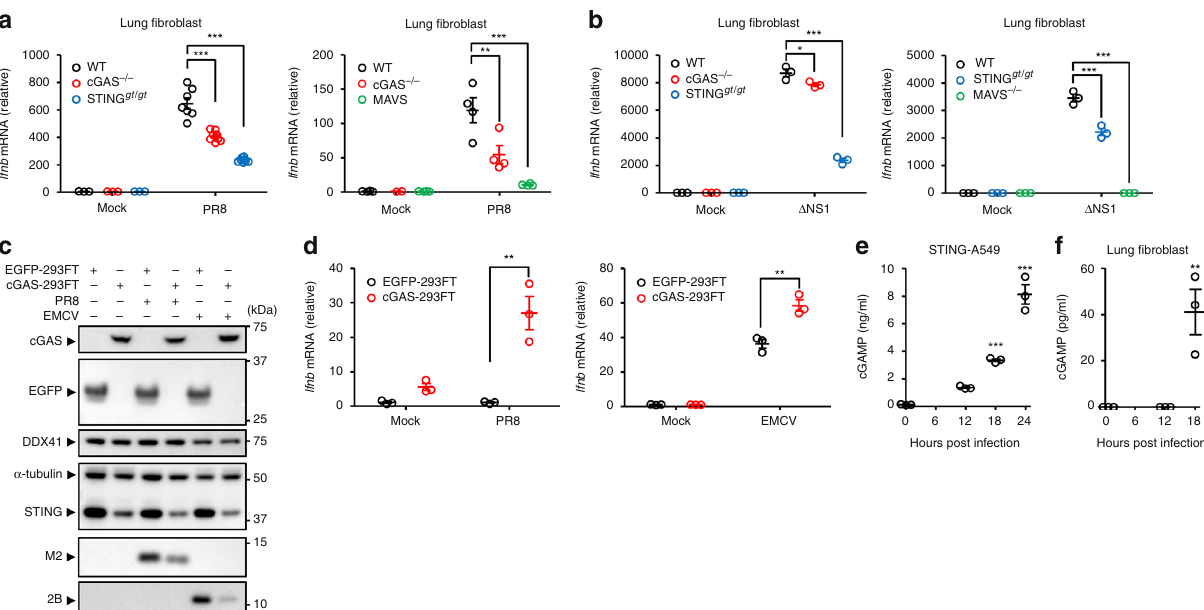
Fig. 4 In fl uenza virus stimulates cGAS- and STING-dependent IFN- β gene expression in mouse lung fi broblast. a , b Primary lung fi broblast prepared from WT, cGAS-, STING-, and MAVS-de fi cient mice were infected with WT PR8 ( a ) or Δ NS1 in fl uenza virus ( b ). IFN- β mRNA levels were assessed by quantitative PCR with GAPDH as an internal control. c Samples from HEK293FT cells stably expressing EGFP (EGFP-293FT) or cGAS (cGAS-293FT) were infected with PR8 or EMCV. Cell lysates were collected at 9 h post infection and blotted using the indicated antibodies. d EGFP-293FT or cGAS-293FT cells were infected with in fl uenza virus (left panel) or EMCV (right panel) for 24 h. IFN- β mRNA levels were assessed by quantitative PCR with β -actin as an internal control. e , f STING-A549 cells ( e ) or lung fi broblasts ( f ) were infected with PR8 virus. Pure cytosolic extracts were collected at indicated time points and analyzed for cGAMP by ELISA. These data are from three independent experiments ( a , b , d – f ; mean ± s.e.m.). * P < 0.05, ** P < 0.01, *** P < 0.001; (one-way ANOVA and Tukey ’ s test). Source data are provided as a Source Data fi dsDNA (Supplementary Fig. 17a, b). In addition, the anti-dsDNA Fig. 13b). Although depletion of mtDNA did not change the antibody coimmunoprecipitated with cGAS, DDX41, and TFAM expression levels of DDX41, RIG-I, MAVS, and STING in cGAS-293FT cells after infection with WT PR8 in fl uenza virus (Supplementary Fig. 13c), ρ 0 HEK293FT cells signi fi cantly (Supplementary Fig. 17b). Further, the biotin-tagged 45 bp reduced the IFN- β gene expression after infection with Δ NS1 interferon stimulatory DNA (ISD) coimmunoprecipitated with in fl uenza virus (Supplementary Fig. 13d). Similarly, ρ 0 cGAS- NS1 and DDX41 in cGAS-293FT cells after infection with WT 293FT cells signi fi cantly reduced the IFN- β gene expression after PR8 in fl uenza virus (Supplementary Fig. 18). Since two basic infection with WT or Δ NS1 in fl uenza virus (Supplementary amino acids at positions 38 and 41 within the NS1 protein are Fig. 14), suggesting that mtDNA is important for in fl uenza virus- known to be important for its dsRNA- or dsDNA-binding induced IFN- β gene expression. Collectively these data indicated activity 45,48,49 , we next examined the role of these two amino acids (R38 and K41) in association between the NS1 protein and that in fl uenza virus infection stimulates cGAS- and DDX41- mtDNA and found that the fl ag-tagged R38A/K41A NS1 mutant reduced association with cytosolic mtDNA after infection with Δ NS1 in fl uenza virus (Fig. 6a). Consequently, the R38A/K41A NS1 mutant failed to inhibit cytosolic translocation of mtDNA and IFN- β gene expression after Δ NS1 in fl uenza virus infection (Fig. 6b). In addition, infection with a recombinant in fl uenza virus expressing the mutant NS1 R38A/K41A protein (rgPR8/ NS1 38/41A ) signi fi cantly enhanced the detectable levels of cytosolic mtDNA and STING-dependent IFN- β gene expression compared to WT virus-infected cells without affecting the expression levels of the NS1 protein (Fig. 6c, d). Collectively these data indicated that in fl uenza virus NS1 protein may associate with mtDNA through its RNA-binding domain to block STING-dependent IFN- β gene expression. or control antibodies in HEK293FT cells after infection with Δ NS1 in fl uenza virus. Although the NS1 protein of in fl uenza virus did not co-localize with dsDNA in cytosol of in fl uenza virus-infected cells (Supplementary Fig. 15), we found that the fl ag-tagged NS1 protein speci fi cally coimmunoprecipitated with cytosolic mtDNA after infection with Δ NS1 in fl uenza virus (Fig. 6a and Supplementary Fig. 16). Similarly, in fl uenza virus NS1 protein was coimmunoprecipitated with an antibody against